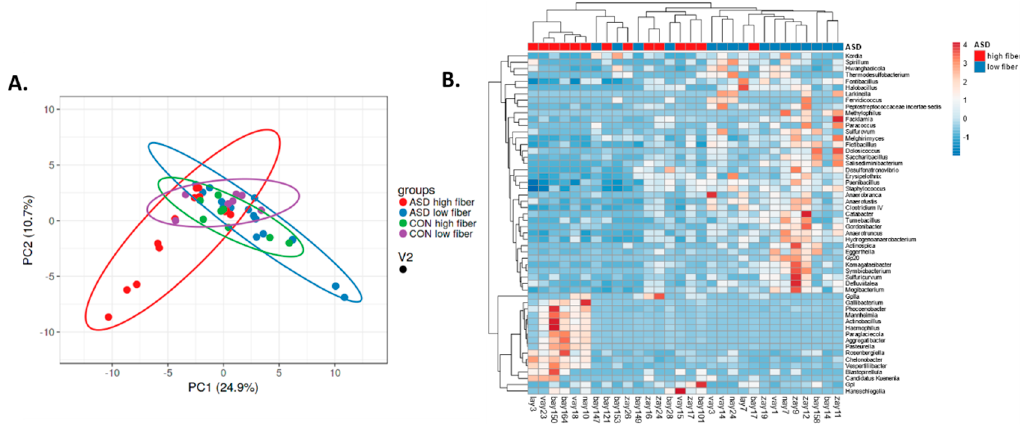
Figure 8. Intestinal microbiota diversity in children with ASD with high or low daily fibre intake, ClustVis. A . PCA. B . Heatmap, significantly differently abundant genera.